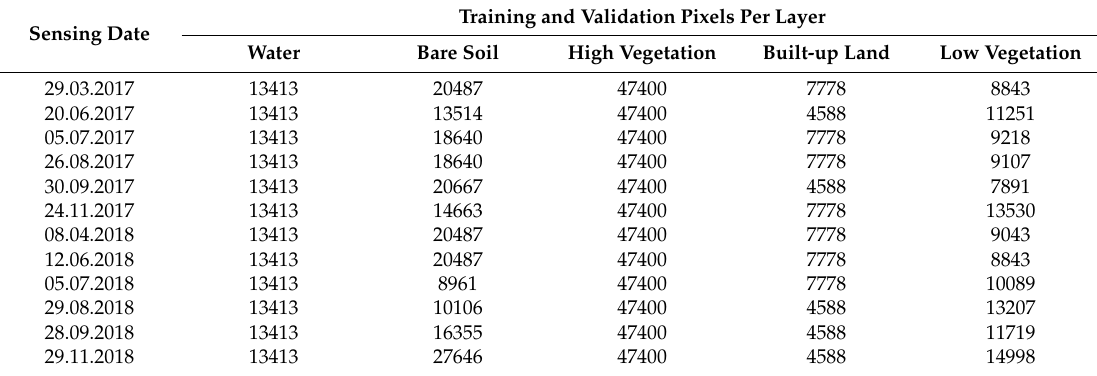
Table 2. Number of pixels per band for training and validation for all five land cover classes per